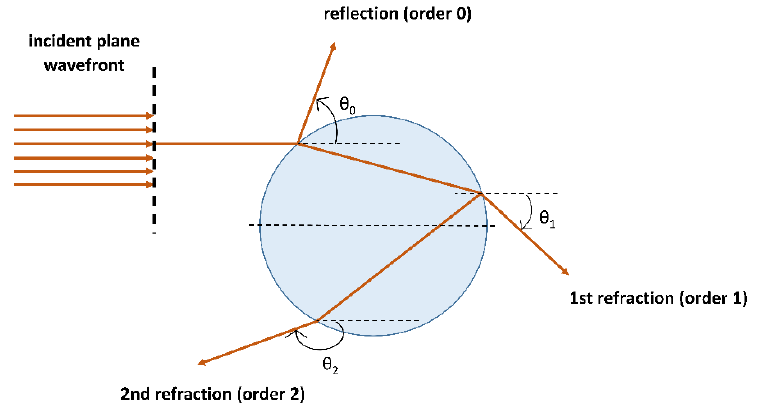
Figure 5. Light paths inside a droplet, illuminated by a plane wave (modified from Lemoine et al.